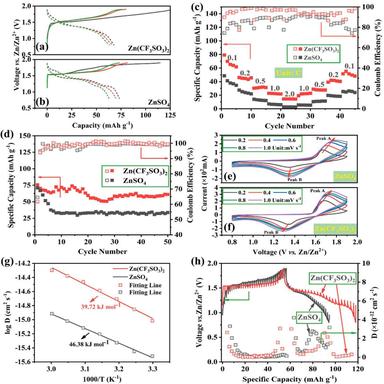
(a and b) The first three cycle profiles; (c) the rate performance; (d) the cycle performance; (e and f) CV curves at different scan rates; (g) plots of logD vs. T−1 at a potential of 1.45 V (vs. Zn/Zn2+) and the fitting lines; (h) GITT curves and calculated Zn2+ diffusion coefficient in 1 M Zn(CF3SO3)2 and 1 M ZnSO4 aqueous electrolyte, respectively.